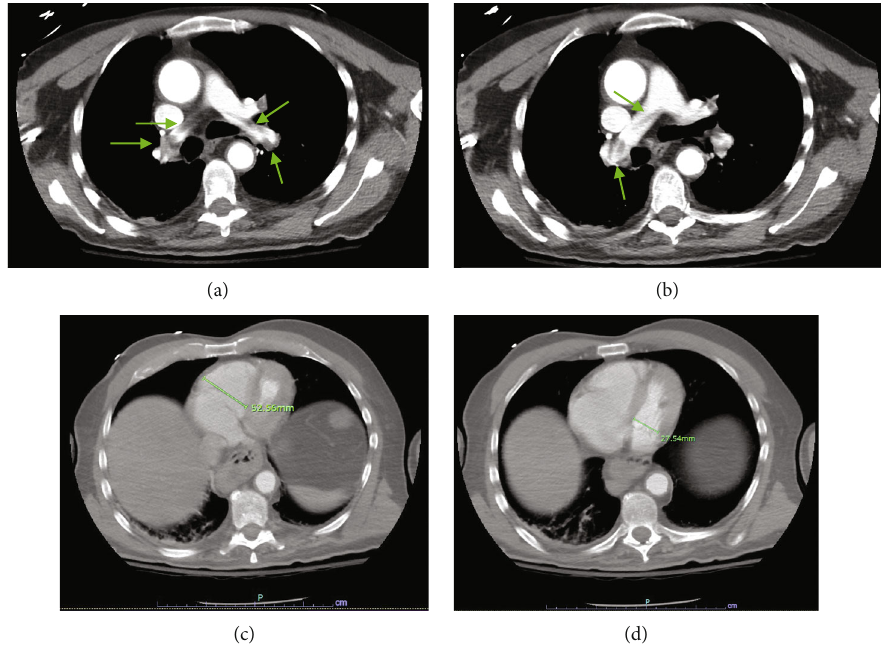
Figure 1: (a, b) Pulmonary embolism on the left and right pulmonary arteries. (c, d) RV and LV measurement demonstrating an RV/LV diameter of 1.9, septal bowing to the left further supports right ventricular